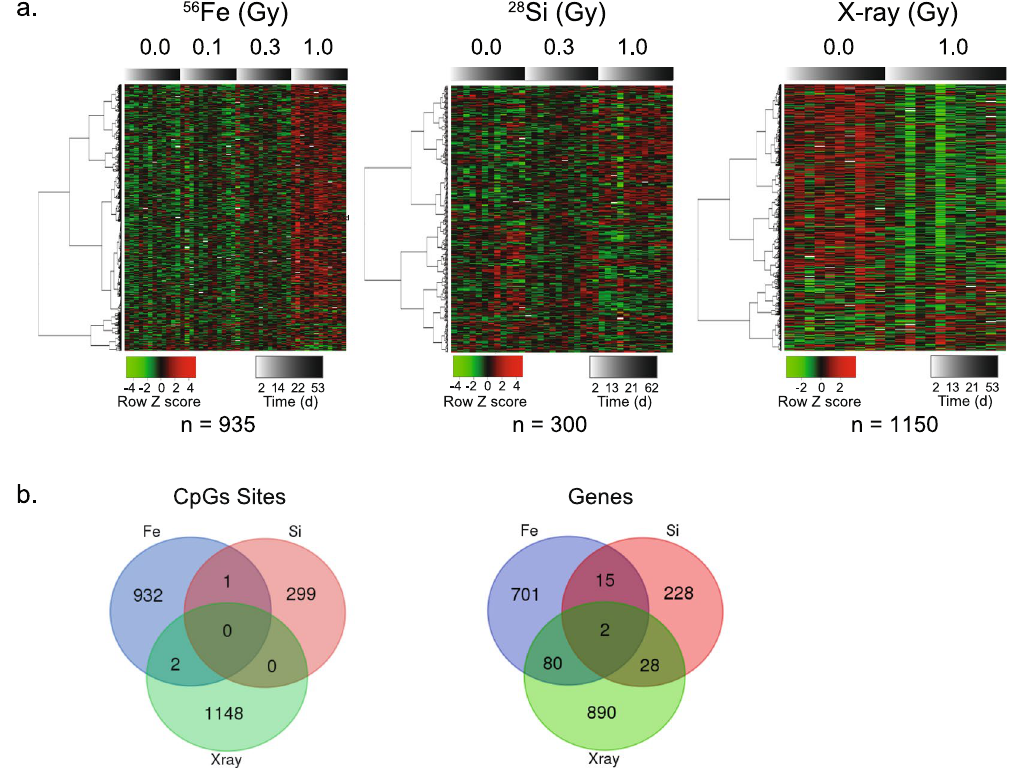
Figure 2. Differential effects of High- ( 56 Fe, 28 Si) or low-LET radiation dose on the methylation status of individual CpG sites. A linear mixed effects model was used to identify DNA methylation changes significantly associated with dose, source, or time-after-exposure (see Methods). This analysis identified 935 CpG sites whose methylation status was moderately (p < 0.001) associated with 56 Fe dose (849 hyper; 86 hypo); 300 CpG sites associated with 28 Si dose (158 hyper, 142 hypo) and 1150 CpG sites associated with X ray dose (252 hyper; 898 hypo). ( a ) Heatmap showing the methylation status (low, green to high, red) of the 56 Fe, 28 Si or X ray significant CpG sites (rows) for each replicate sample analyzed (columns). Samples (columns) are arranged from left to right by increasing time after exposure (shaded gray bar, n = 3 for each time point) for the indicated dose (n = 12 for each indicated dose; 4 time points in triplicate). ( b ) Overlap between individual CpGs sites (left) or nearest RefSeq gene (right) among CpGs differentially methylated in response to 56 Fe, 28 Si, X ray. Note the largely distinct CpGs affected by each radiation